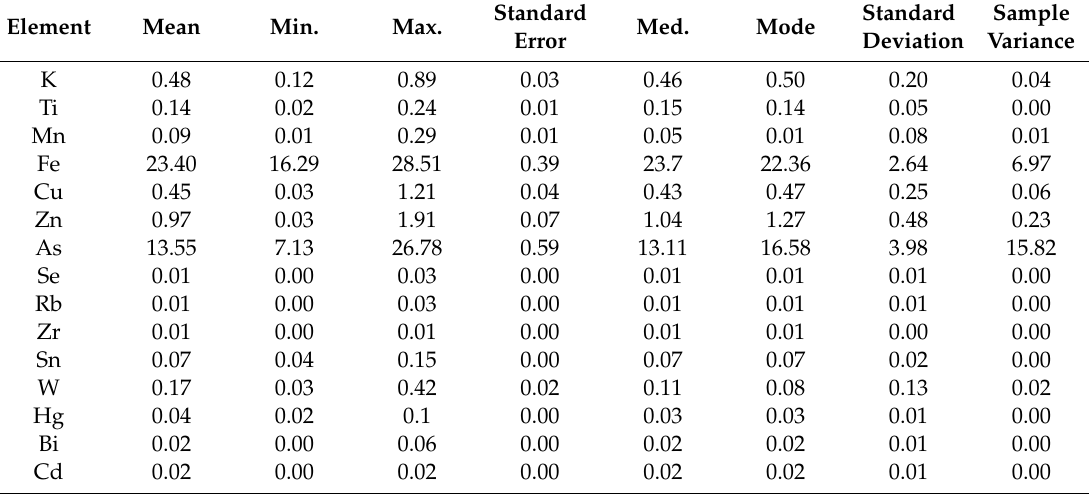
Table 2. Descriptive statistics of chemical elements in tailings from Cabeço do Pi ã o samples [14]. Element Mean